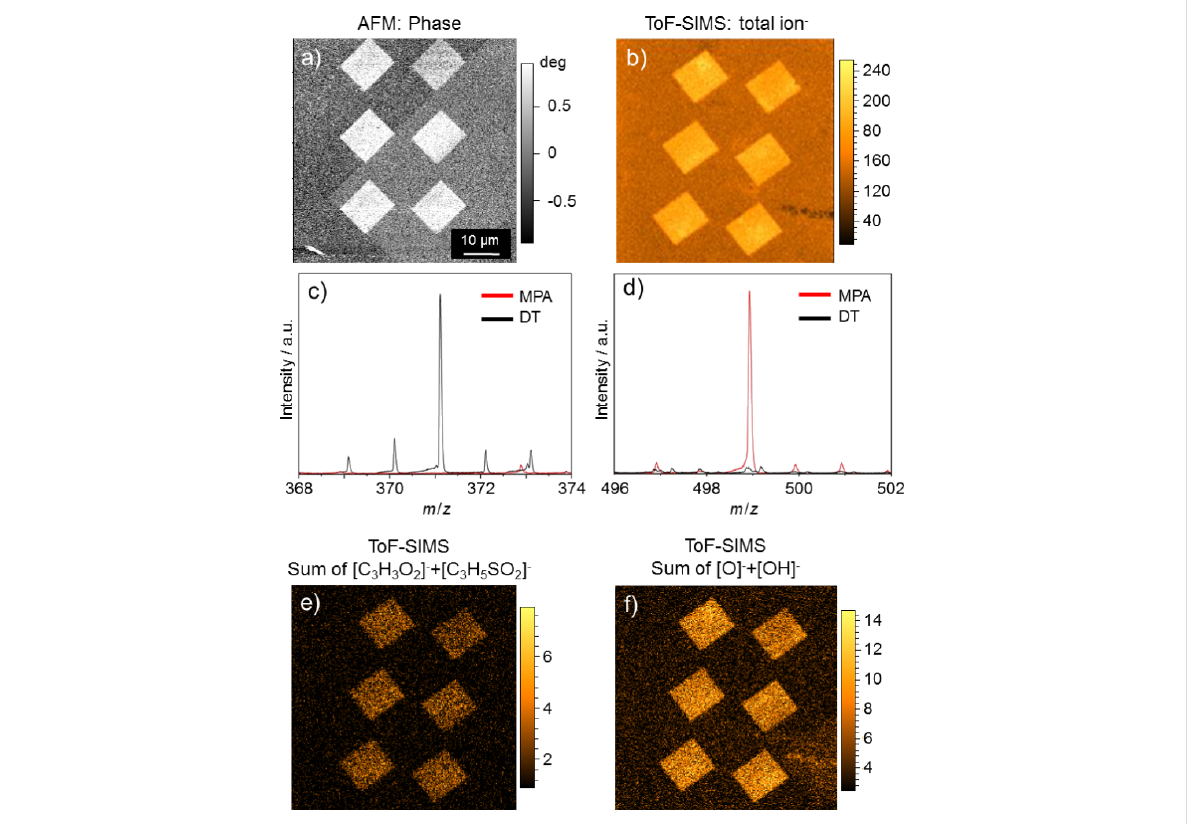
Figure 4: (a) AFM phase contrast image of six rectangles consisting of MPA grafted into a DT matrix SAM. (b) Negative polarity total secondary ion mapping. (c) High mass resolution SIMS data for DT (black line) and MPA (red line), the peak at m / z 371 in (c) is attributed to [AuSC 10 H 22 ] − , the Au cluster ion of DT, (d) as (c) the peak at m / z 499 is assigned to [Au 2 SC 3 H 5 O 2 ] − , the Au cluster ion of MPA. Other characteristic peaks are found at m / z 105, [C